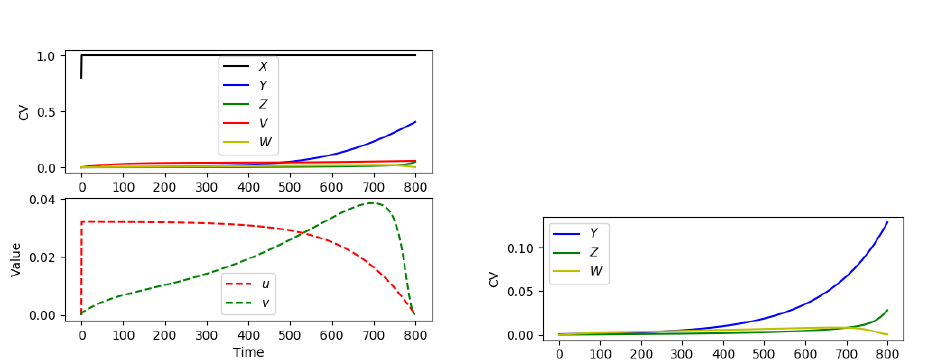
Figure 5. Numerical Optimal Control and Treatment Simulation Results - High Immunotherapy Side Effect